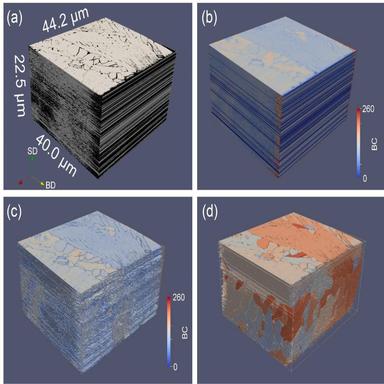
The raw random dataset colored by (a) error (b) band contrast (BC), (c) masked using both error and BC to remove bad data and colored by BC, and (d) aligned using a misorientation based alignment with a tolerance of 1◦ and colored based on the magnitude of the Euler angles.